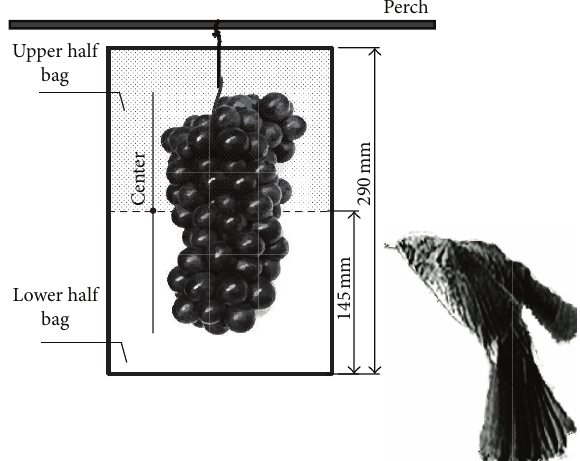
Figure 1: This study design figure shows a cluster of grapes suspended from a perch. Three basic test methods were used: (1) no bag present (uncovered); (2) half covered/half-visible grape cluster (half-visible bag); and (3) the entire cluster of grapes inside a white bag (full bag). The illustration shows a “half-visible bag,” with the upper half white (black shaded in this figure) and the lower half made of clear film. The white paper bag covered grapes like a skirt; therefore, the birds could look into the white paper bag through the clear film (the lower half bag). Full bags were completely made of white paper. Birds fed on uncovered grapes but could not feed directly on grapes that were covered in the “half-visible bag” or the “full